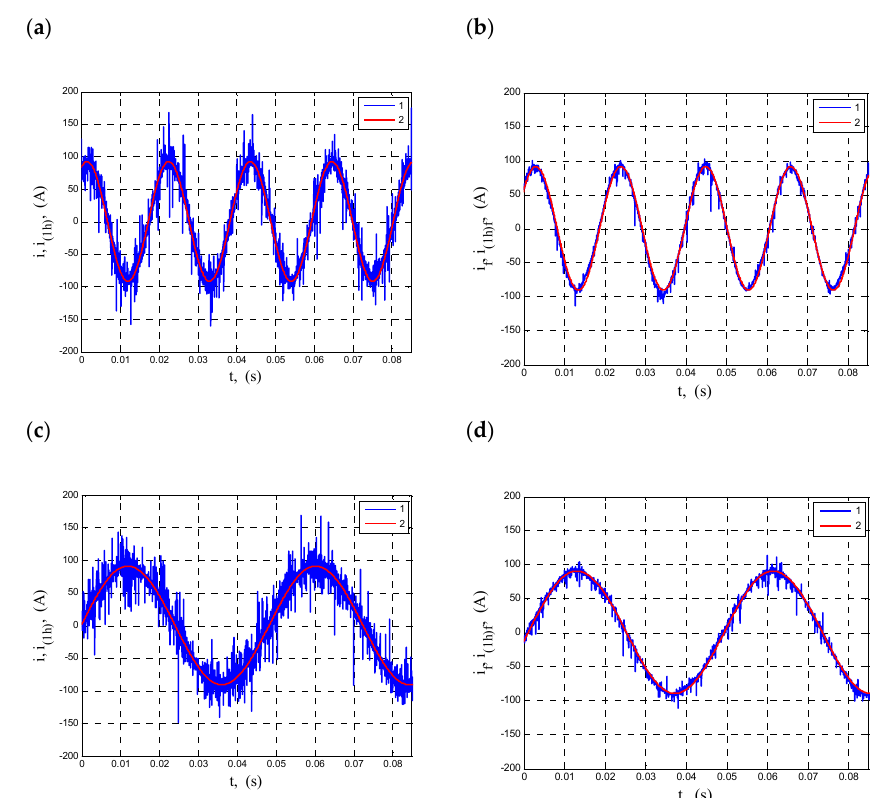
Figure 8. Estimated waveforms of the fundamental harmonic of the motor’s stator current against the background of the measuring signal at the input ( a , c ) and the output of the analog filter ( b , d ) with the frequencies ( a , b ) 47.61 Hz and ( c , d ) 20.67 Hz; 1—measurement data, 2—identified current fundamental